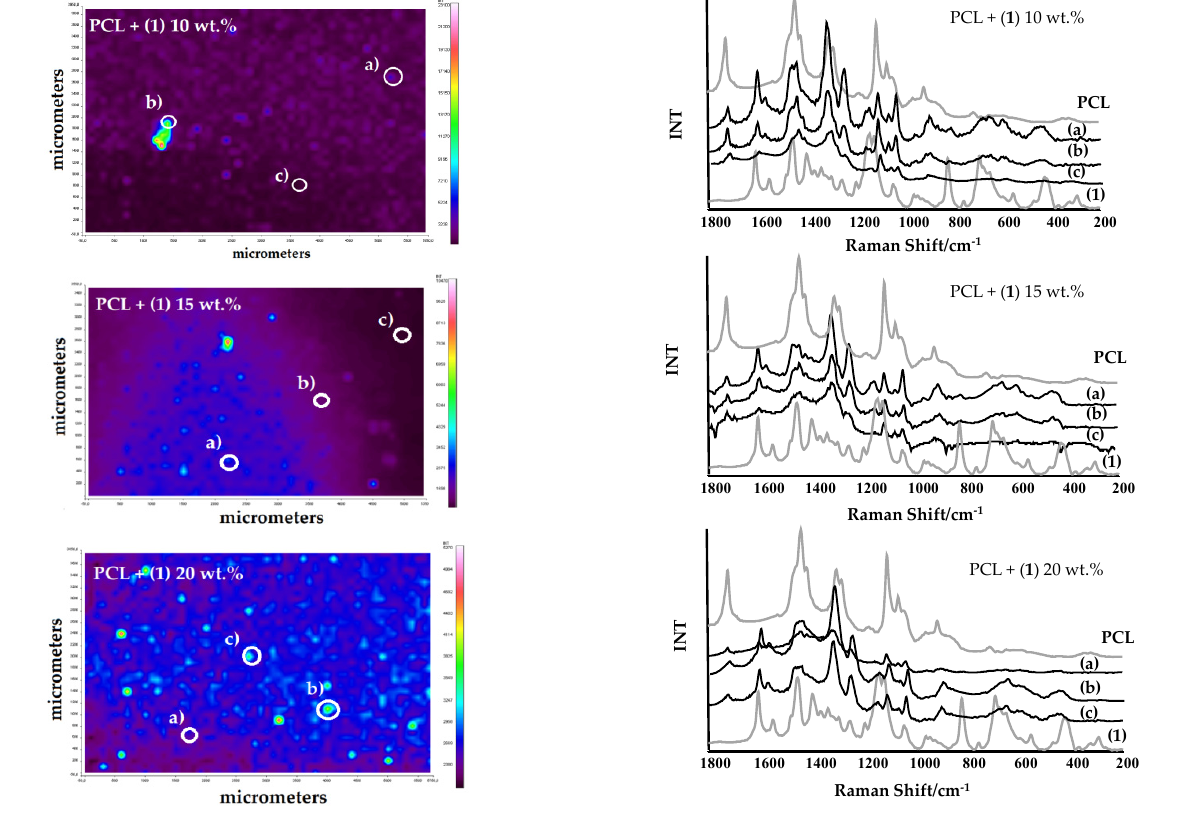
Figure 5. Raman microscopy maps and Raman spectra registered in selected points of the PCL + ( 1 ) composites.